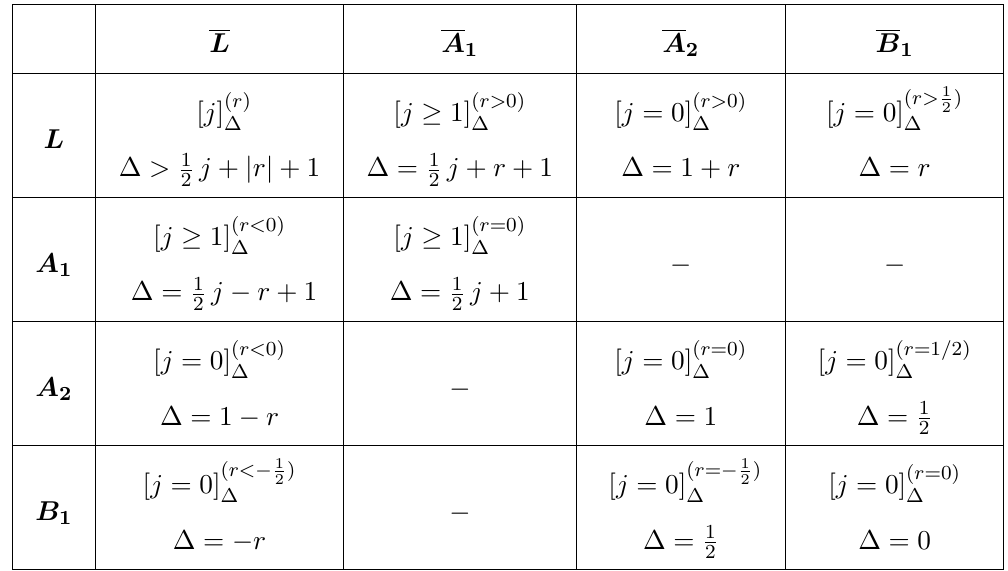
Table 4 . Consistent two-sided multiplets in three-dimensional N = 2 theories. A dash ( (cid:0) ) indicates that the corresponding multiplet does not